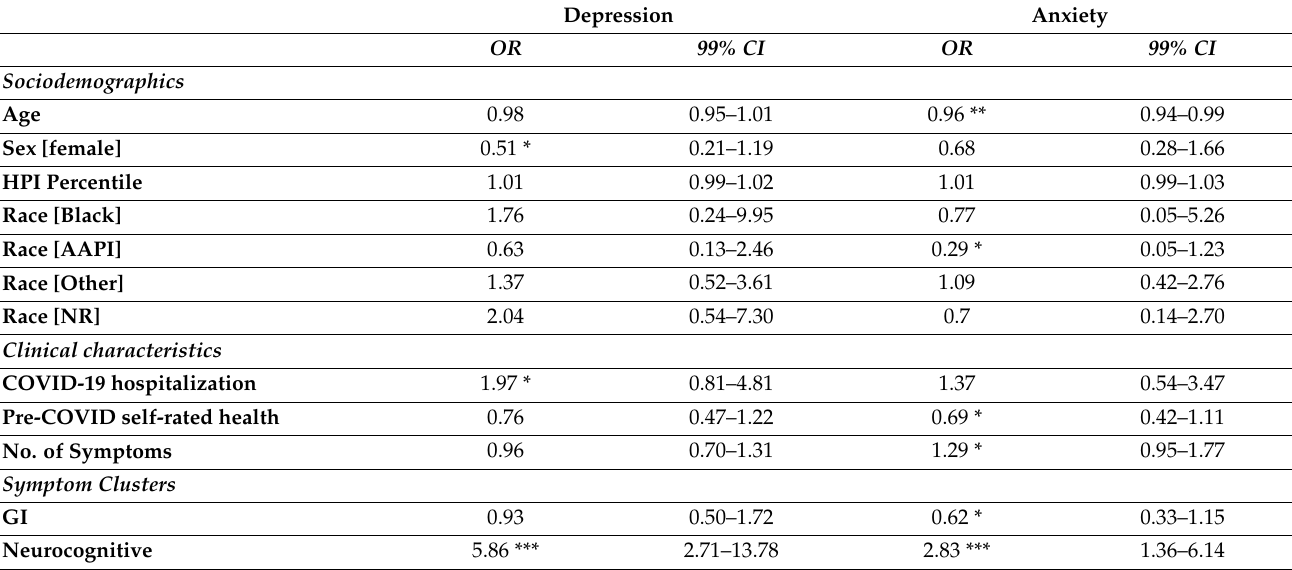
Table 3. Sociodemographic, clinical, and symptom cluster predictors of depression and